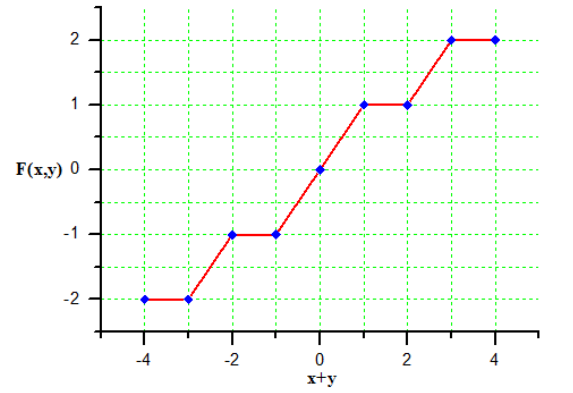
Figure.3 Logical function F(x, y)